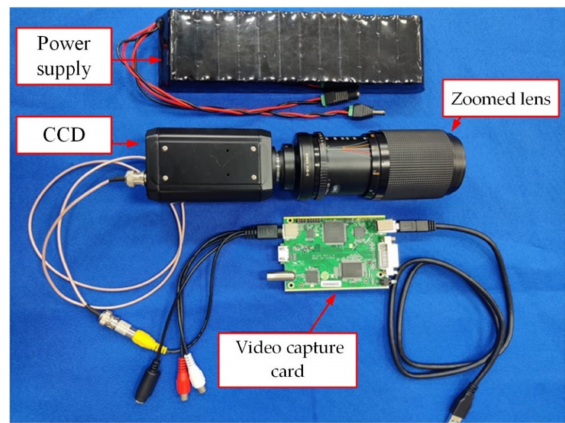
Figure 12. Imaging detection system.